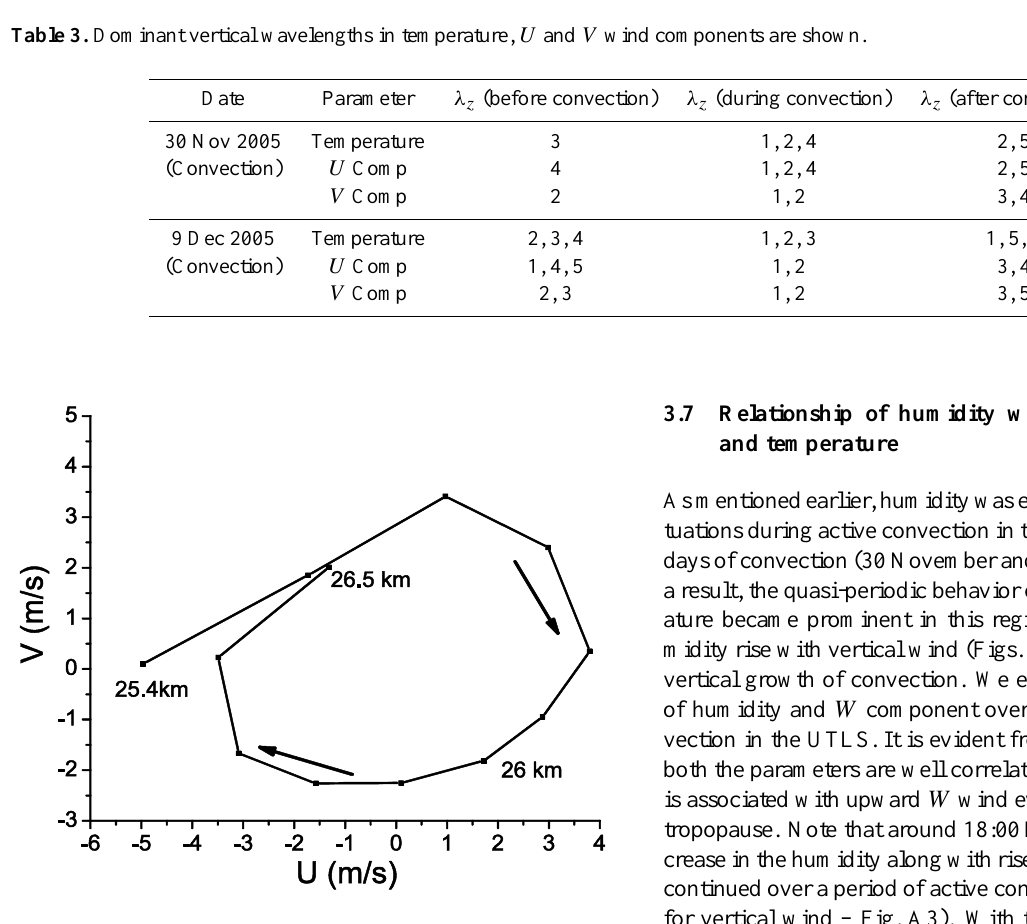
Fig. 12. Hodograph between 25.4km and 26.5km height on Figure 12 . Hodograph between 25.4 km and 26.5 km height on 30 Nov 05. Hodograph ellipse completed 30 November 2005. Hodograph ellipse completed within ∼ 1km within ~ 1 km height.